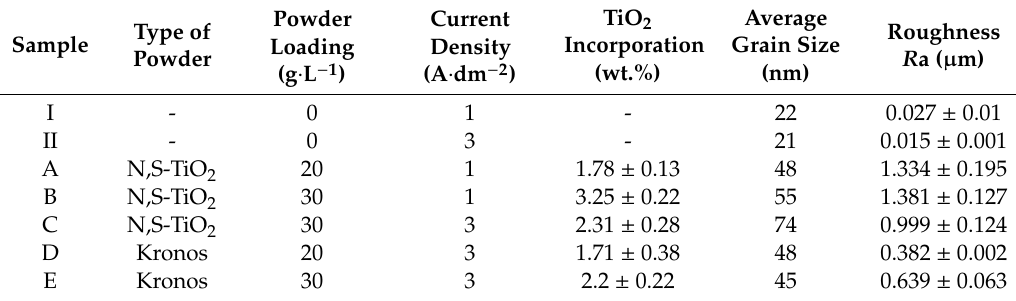
Table 3. TiO 2 incorporation (wt.%), average grain size (nm), and roughness ( μ m) values of pure Sn–Ni and